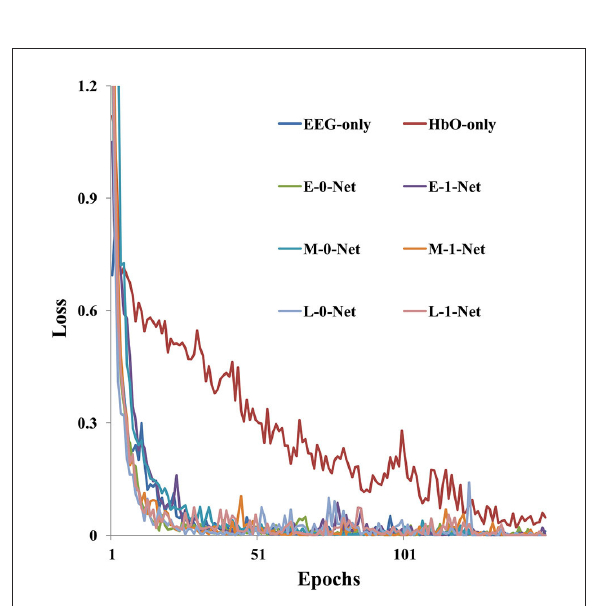
disturb the temporal-spatial characteristics of original fNIRS data and maintained good